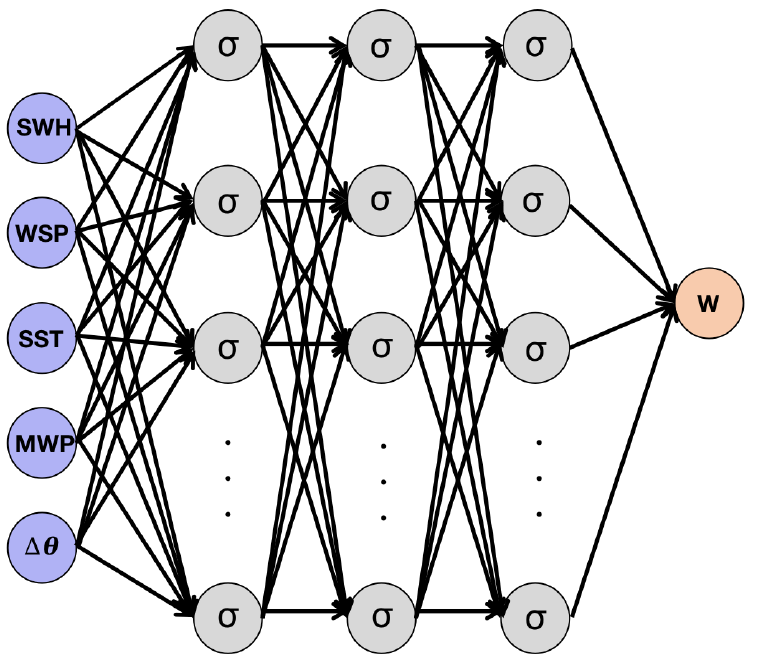
Figure 2. Structure of DNN-based whitecap fraction ( W ) parameterization, σ is the neuron in the hidden layer.